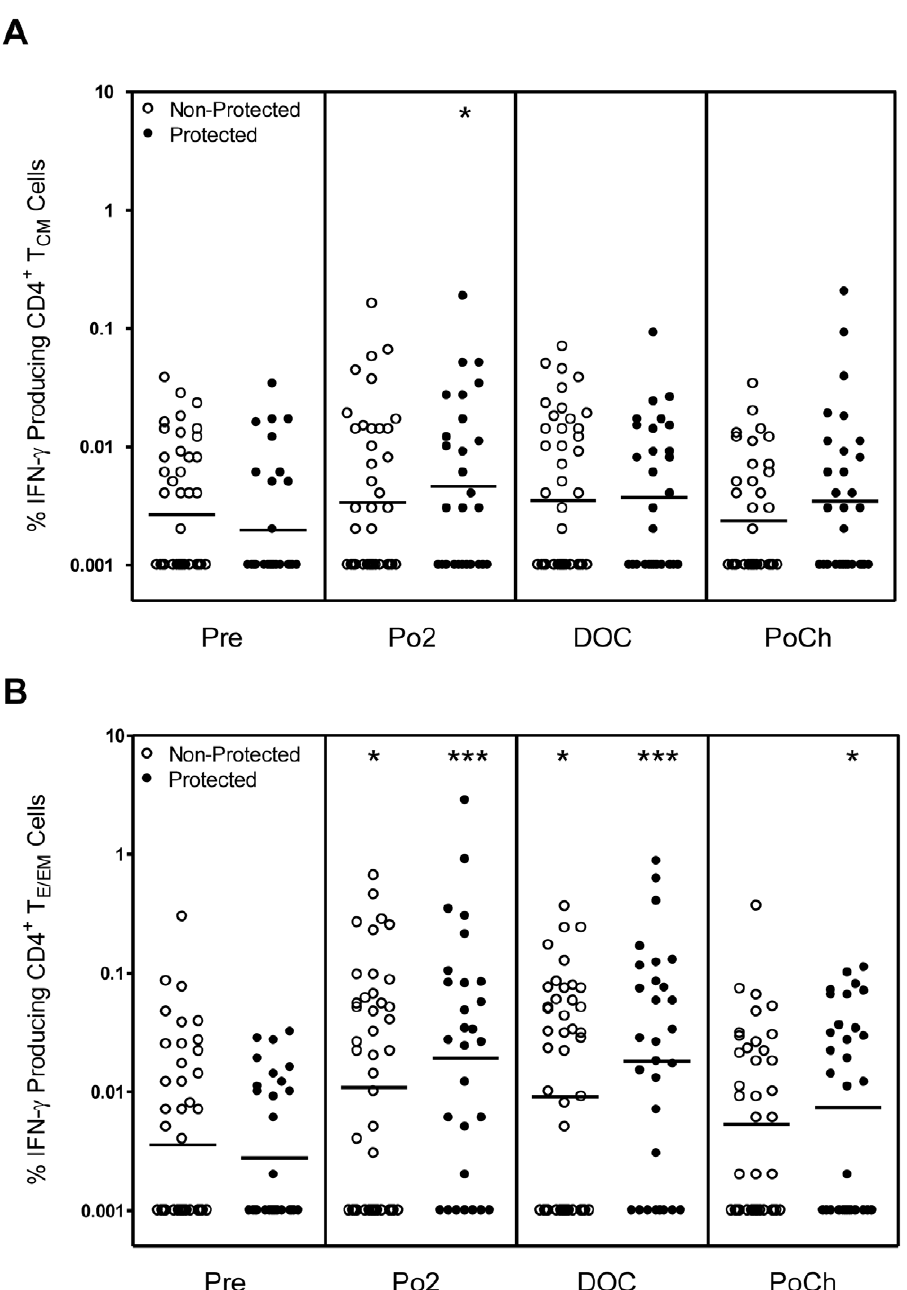
Figure 5. Frequency of CD4 + T CM and CD4 + T EM cells producing IFN- c upon recall with CSP peptides. PBMC were obtained at the indicated time points from RTS,S-immunized subjects and were incubated as in Fig. 3 with CSP peptides as described in Methods. Cells were then analyzed as described in the legend to Fig. 1. The resulting values are plotted as the % of [A] IFN- c producing CD4 + T CM cells and [B] IFN- c producing CD4 + T E/EM cells for protected (closed symbol) and non-protected (open symbol) subjects. Statistically significant differences between pre-immune and post-vaccination time points are indicated at the top of the graph. Statistically significant differences between values for protected and non- protected subjects are as indicated within the body of the graph. *p , 0.05; **p , 0.01; ***p , 0.001.